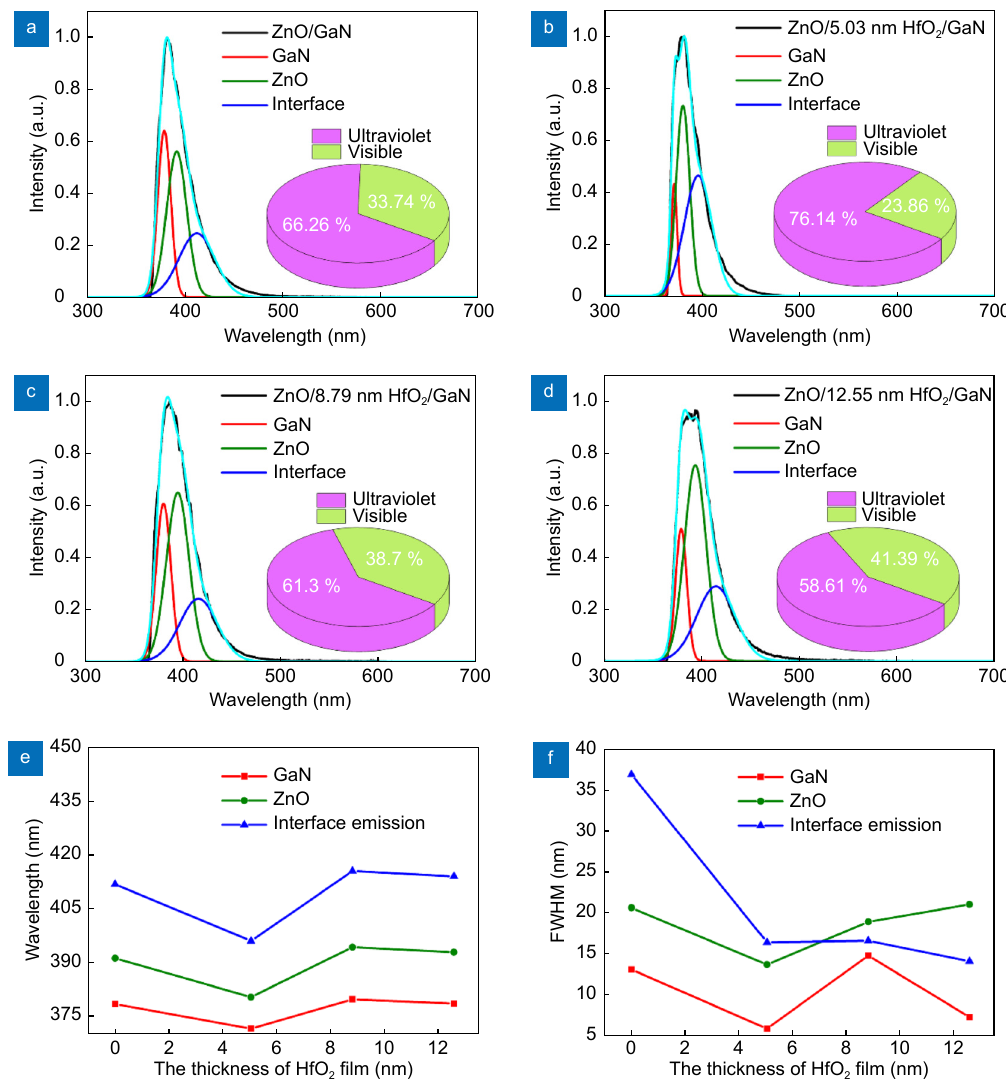
Fig. 6 | Gaussian conversion of Fig. 5(c)−5(f) at a current of 1 mA : ( a ) 0 nm, ( b ) 5.03 nm, ( c ) 8.79 nm, ( d ) 12.55 nm, and the inset images de- pict the contents of UV and visible lights. ( e ) The peak positions of emissions and ( f ) FWHM of emissions for these